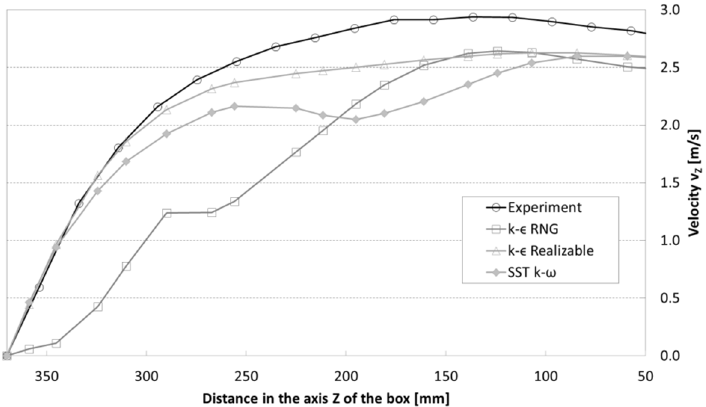
Figure 12. Distribution of v z velocity component in plenum box with side entry in the Z direction for Y = 0 mm for variant M5 using different turbulent models.